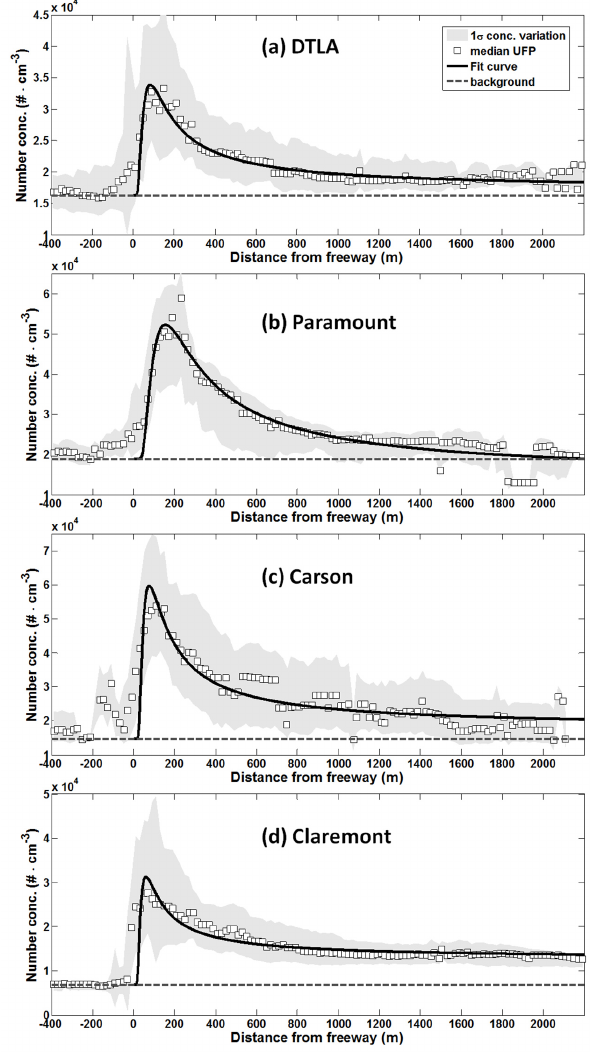
Figure 2. Observed median UFP number concentrations with dis- tance downwind of freeways (white squares), 1 σ variation ranges (gray areas), upwind background concentrations (horizontal gray dashed lines), and the semi-empirical GB model fits to the obser- vations (black lines) for transects at (a) DTLA, (b) Paramount, (c) Carson, and (d)